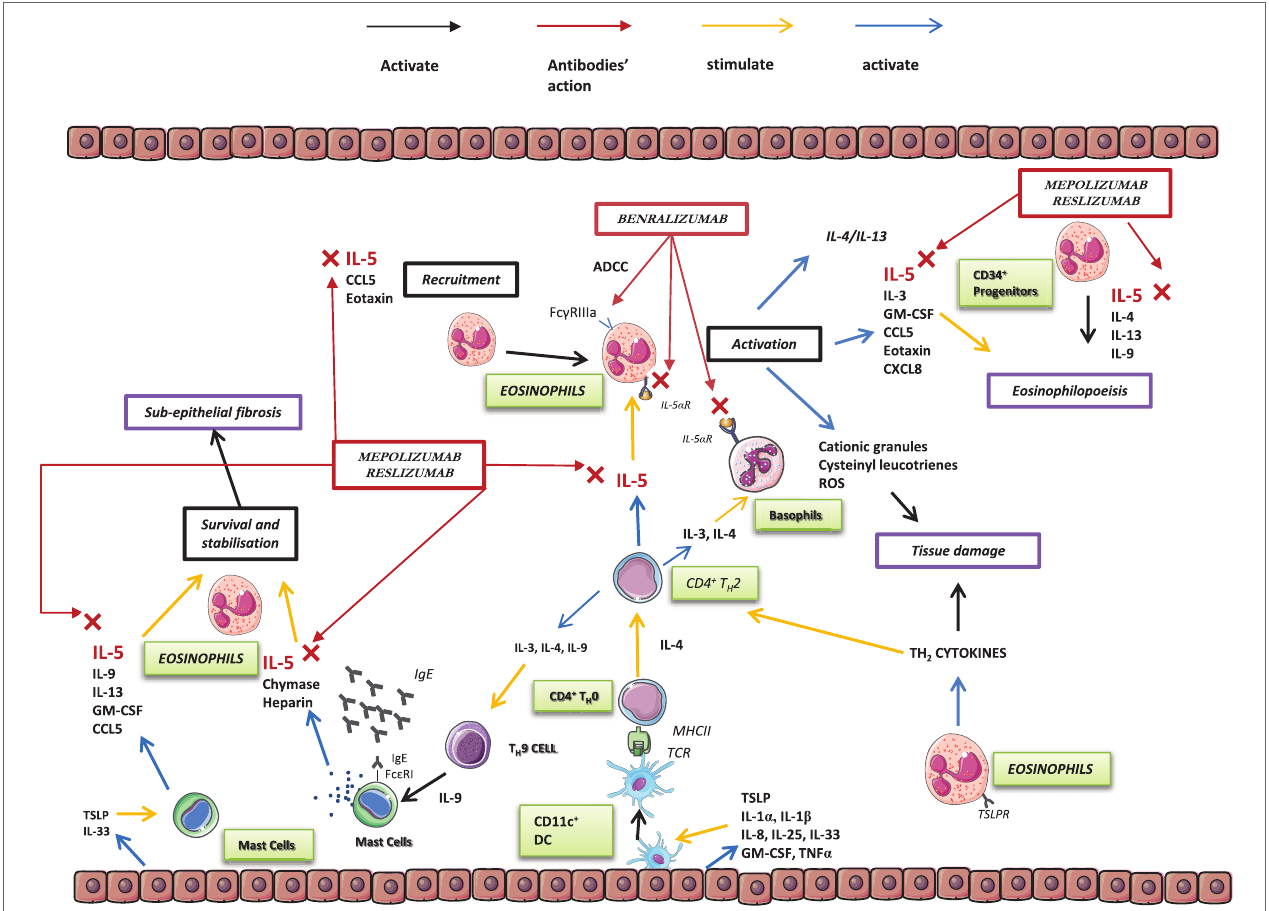
FiGURe 1 | The role of interleukin 5 (IL-5) and eosinophils in